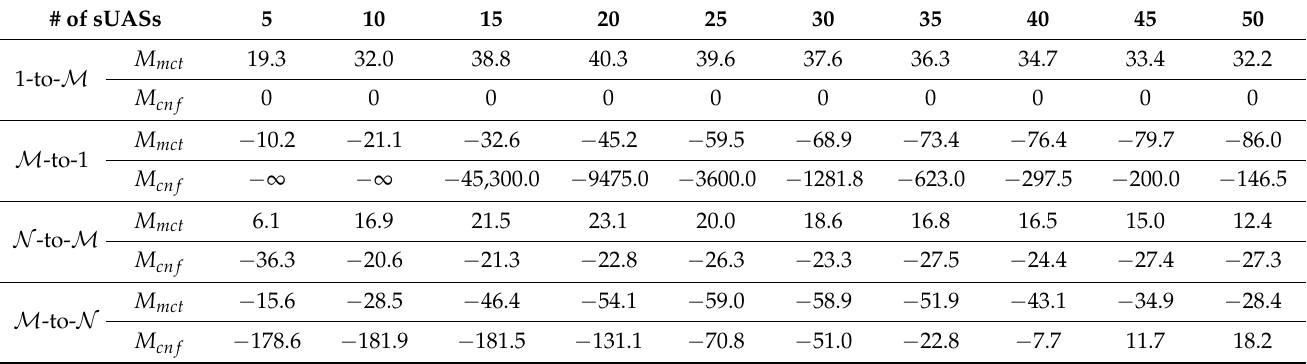
Table 6. The improvement in M mct and M cnf between the FCFS and LCFS algorithms